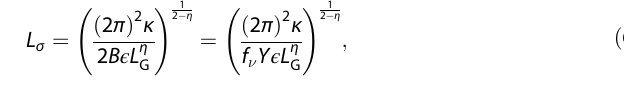
(cid:1) 1 with A the surface area of the de fl ected membrane and A 0 = π L 2 /4 that of the fl at drum, then for